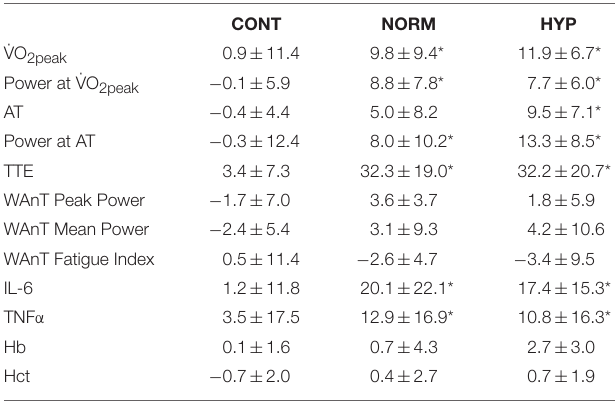
TABLE 2 | Change (%) in aerobic capacity, time to exhaustion (TTE), bloods and inflammatory measures in each group.